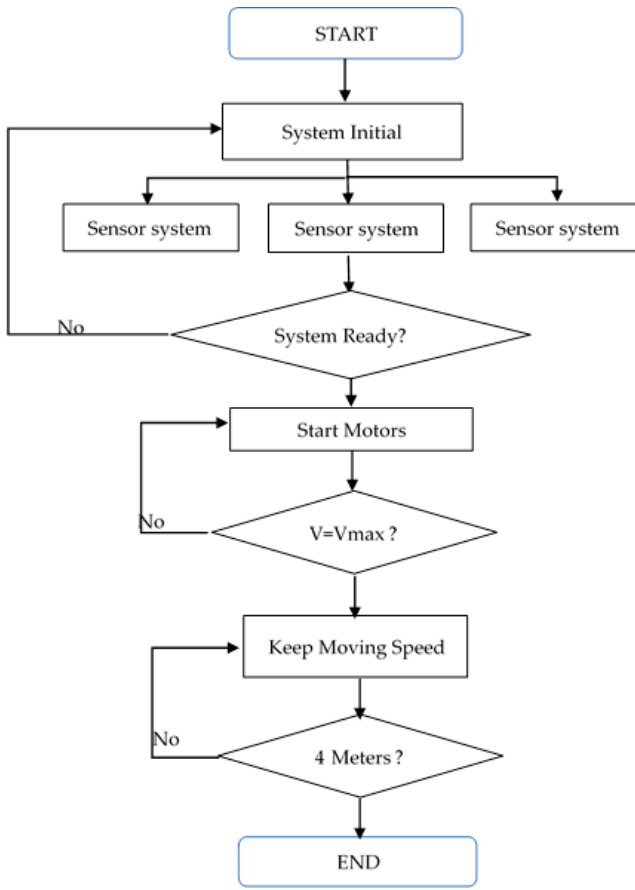
Figure 11. Flowchart of the robot’s motion.